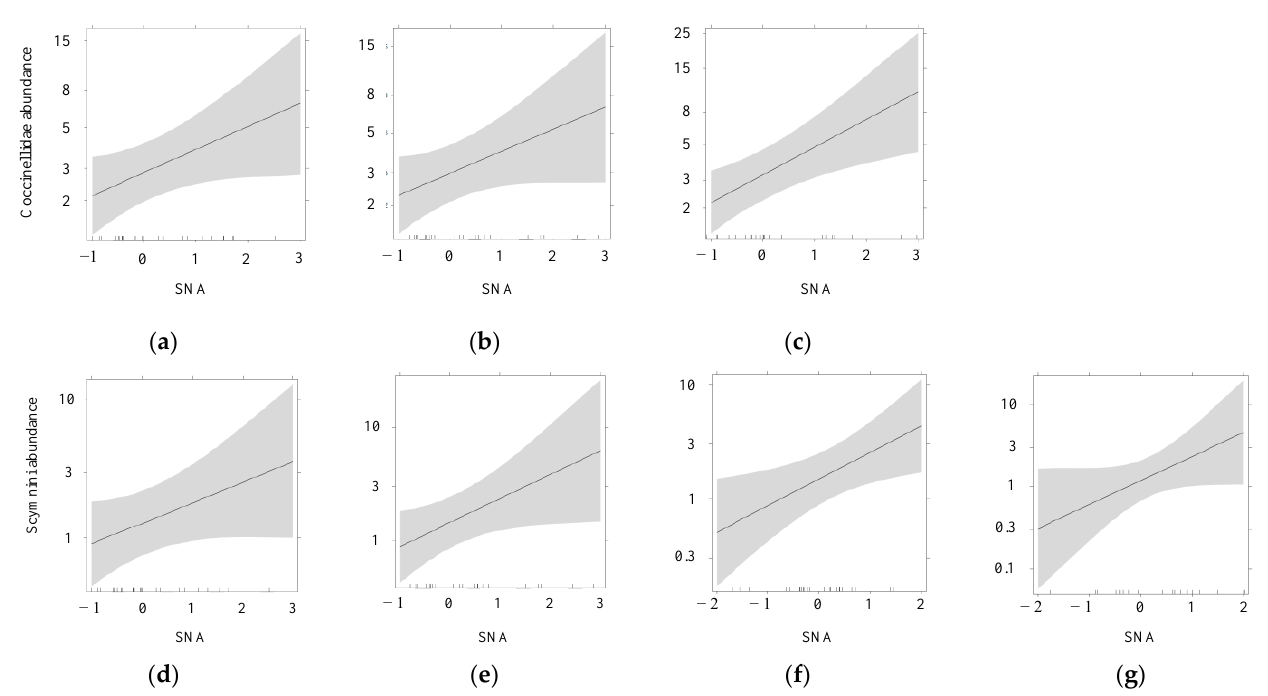
Figure 3. Response of the Coccinellidae and Scymnini abundance to Seminatural areas (SNA) (standardized) surrounding vineyards at different buffers (Coccinellidae: ( a ) — 500 m; ( b ) — 750 m; ( c ) — 1000 m; Scymnini: ( d ) — 500 m; ( e ) — 750 m; ( f ) — 1500 m; and ( g ) — 2000 m).